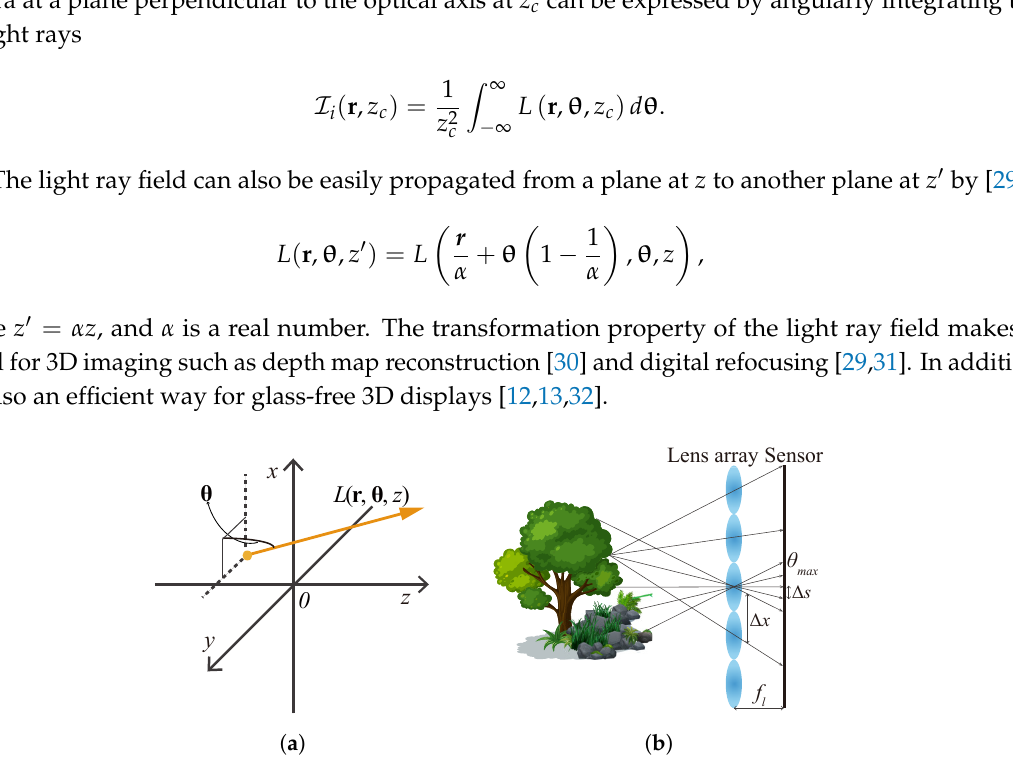
Figure 4. Light field ( a ) and its conventional capture ( b